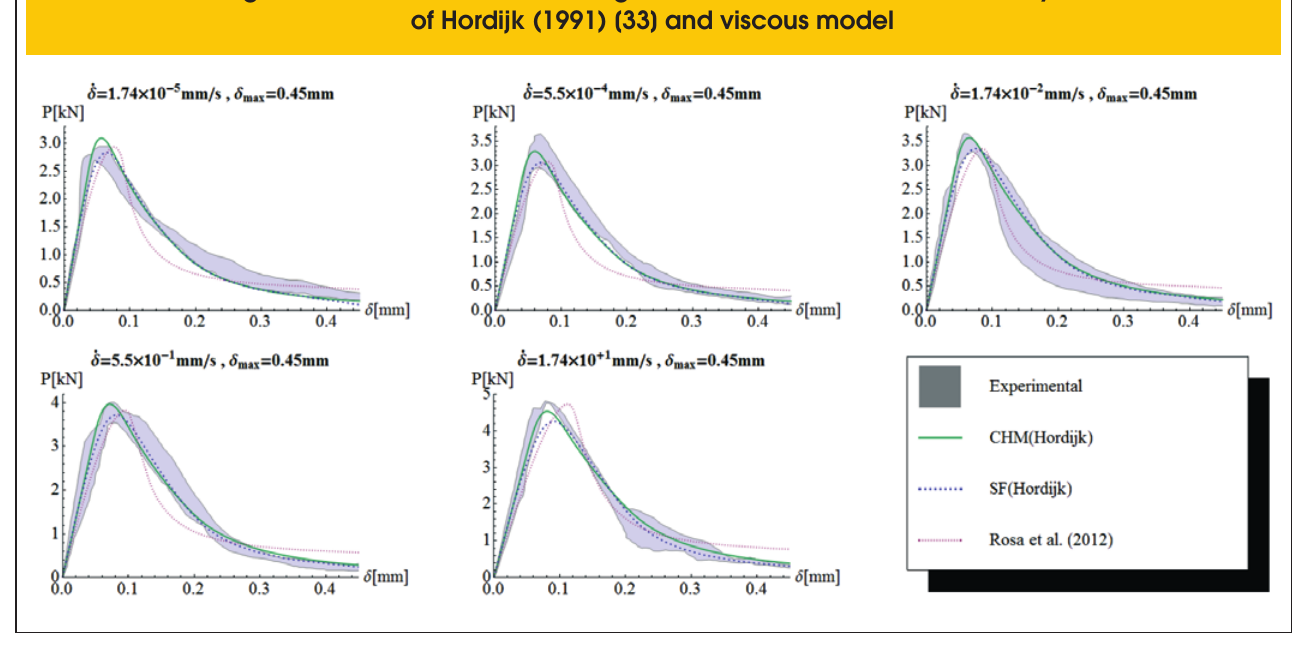
Figure 19 – curves for the range of 0 to 0.45 mm of simultaneously fit P- d of Hordijk (1991) [33] and viscous model